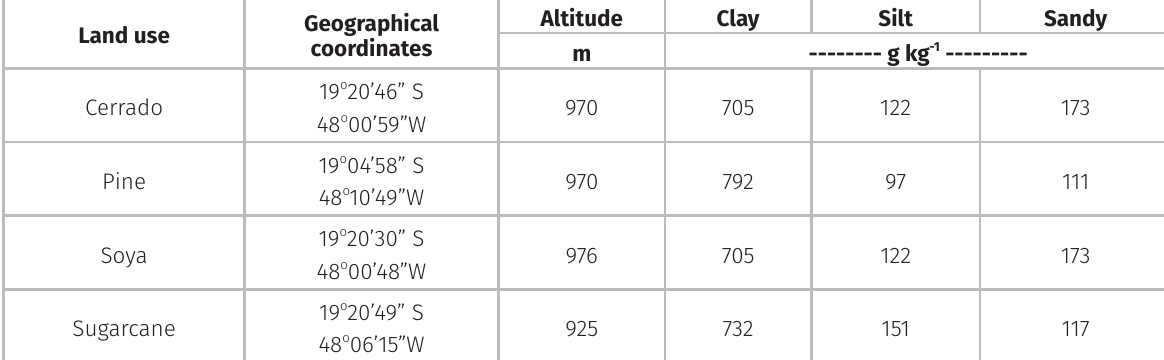
Table I. Sites and soil characterization of different land use